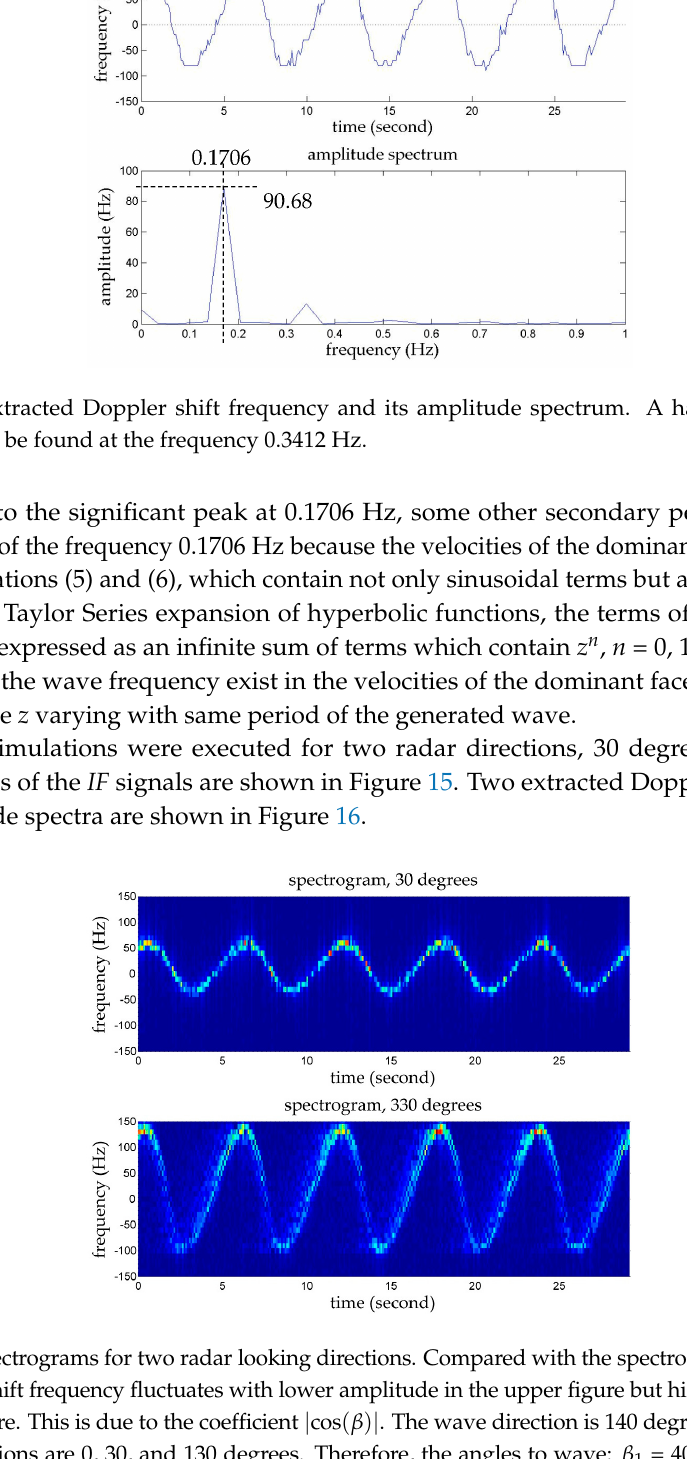
Figure 15. Spectrograms for two radar looking directions. Compared with the spectrogram in Figure 13, the Doppler shift frequency fluctuates with lower amplitude in the upper figure but higher amplitude in the lower figure. This is due to the coefficient | cos ( β ) | . The wave direction is 140 degrees, and the radar looking directions are 0, 30, and 130 degrees. Therefore, the angles to wave: β 1 = 40 degrees, β 2 = 70 degrees, β 3 = 10 degrees and the coefficients: | cos ( β 1 ) | = 0.766, | cos ( β 2 ) | = 0.342, | cos ( β 3 ) | =